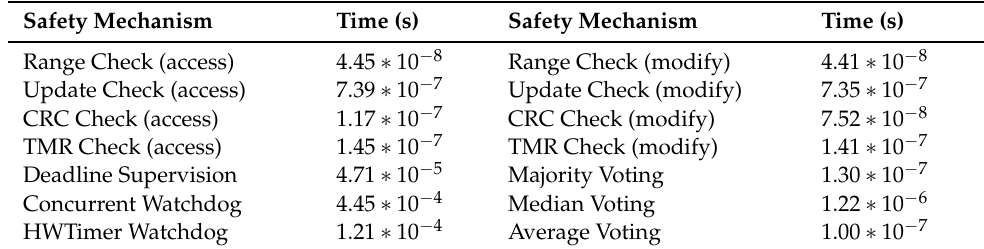
Table 1. Absolute runtime overhead of the generated safety mechanisms.